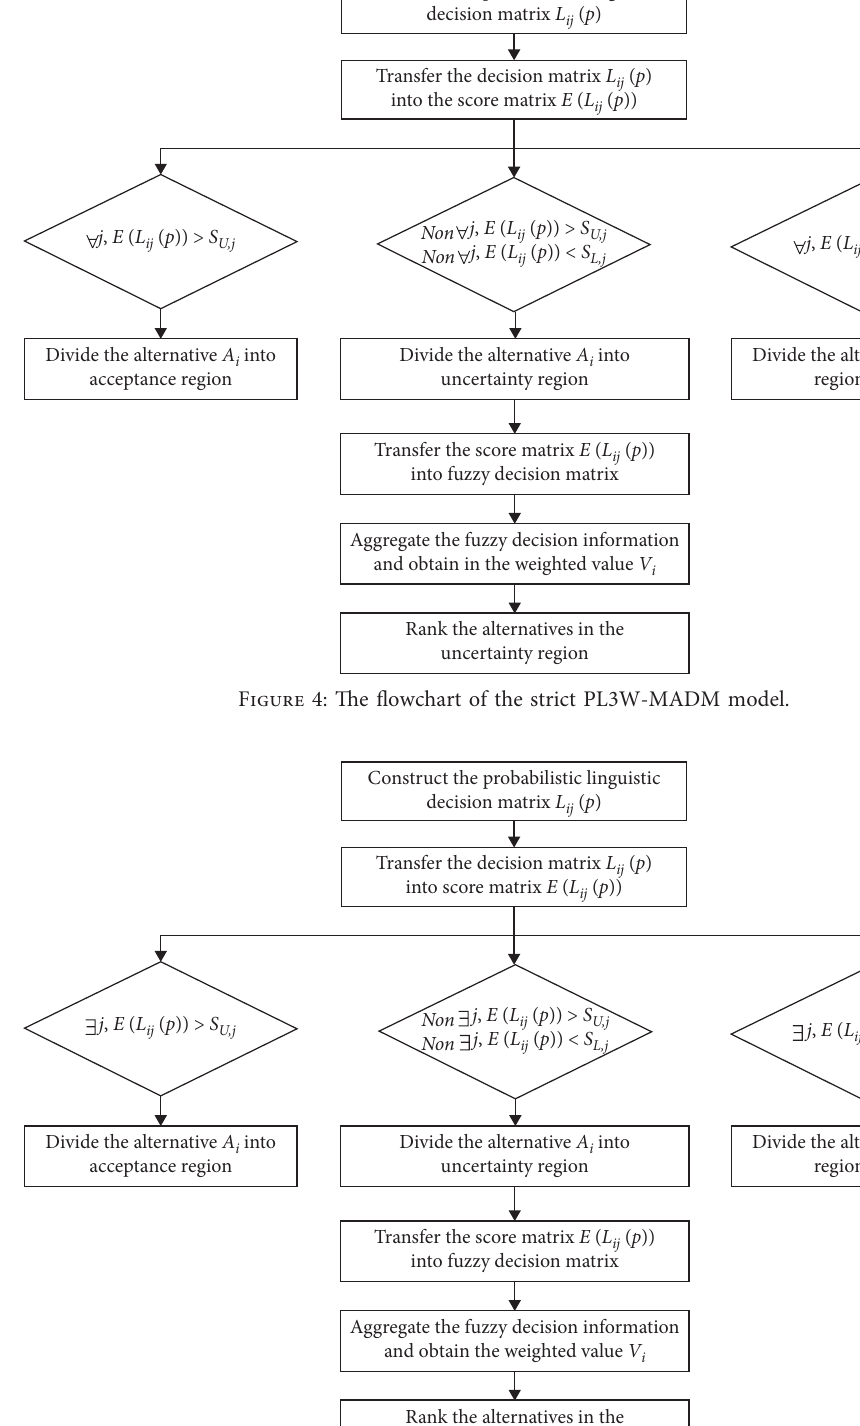
Figure 5: The flowchart of the hidden property evaluation of judgment debtor based on the PL3W-MADM model.